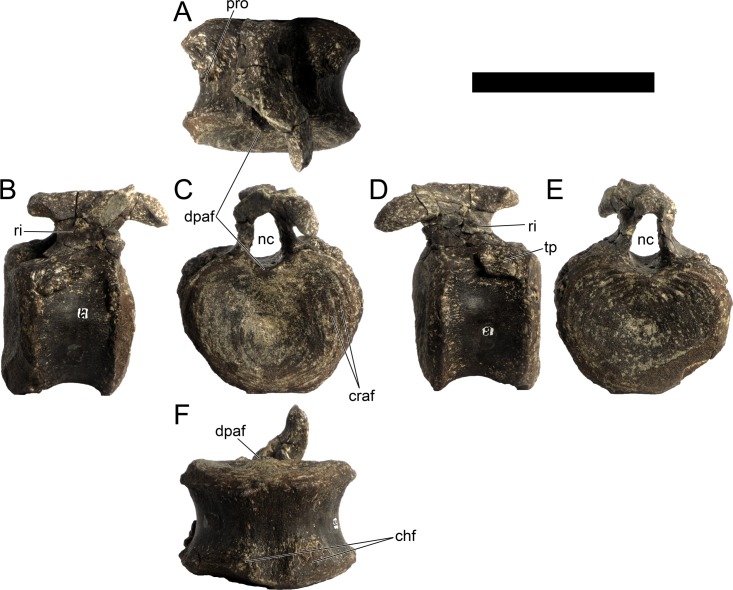
Caudal vertebra 18 of Miragaia longicollum MG 4863.A, dorsal, B, right lateral, C, anterior, D, left lateral, E, posterior, and F, ventral view. Chf, chevron facets, craf, concentric ridges of articular facet, dpaf, dorsal process of articular facet, nc, neurocanal, pro, process, ri, ridge. Scale bar equal to 10 cm.